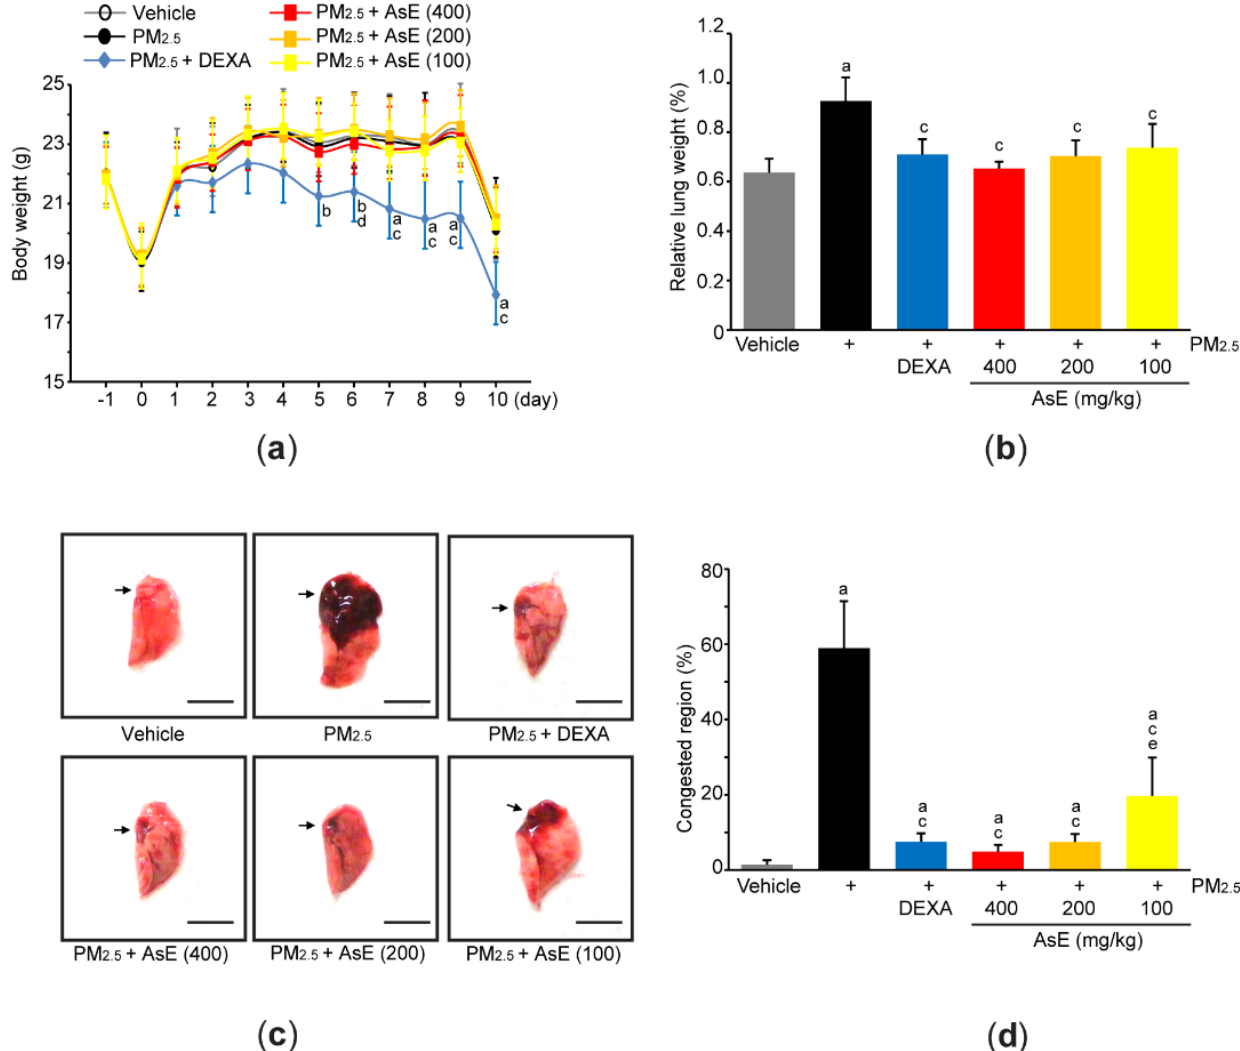
Figure 2. AsE attenuates pulmonary congestion induced by PM 2.5 . ( a ) Changes in body weight were monitored during entire experimental period. ( b ) Relative lung weight was calculated as described in Materials and Methods section. ( c ) Representative image of the left lung lobe. Arrows indicate congested region, and scale bars indicate 6.0 mm. ( d ) Congested region in the left lobe was calculated using an automated image analyzer. a p < 0.01, b p < 0.05 versus vehicle group; c p < 0.01, d p < 0.05 versus PM 2.5 group; e p < 0.05 versus PM 2.5 + DEXA group; DEXA, dexamethasone; PM 2.5 , particulate matter 2.5.